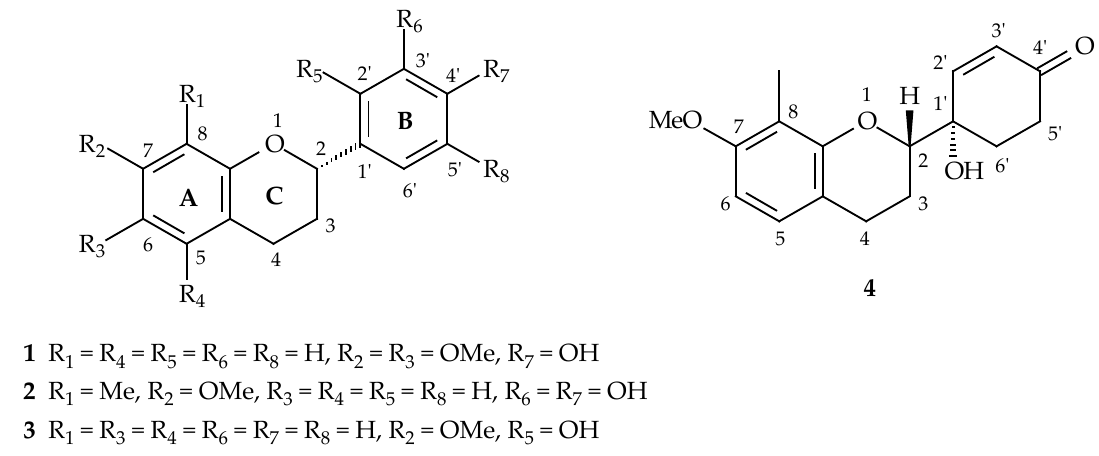
Figure 1. The chemical structures of new flavans ( 1 – 4 ). The methanolic extract of the aerial part of D. ensifolia was partitioned into EtOAc- and water-soluble layers. The new flavan ( 1 ) and 48 known compounds including 7 fla- vans ( 8 – 14 ), 5 flavanones ( 15 – 19 ), 2 flavones ( 21 – 22 ), 2 chalcones ( 26 – 27 ), 2 chromones ( 29 – 30 ), 10 aromatics ( 36 – 45 ), 4 phenylpropanoids ( 49 – 52 ), lignin ( 53 ), 4 steroids ( 54 – 57 ), a monoterpene ( 61 ), one diterpene ( 62 ), 4 triterpenes ( 63 – 66 ), a carotenoid ( 67 ), two alka- loids ( 68 – 69 ), and two fatty acids ( 70 – 71 ) (Figure S1) were isolated from the EtOAc-soluble layer of methanolic extract of the aerial part.